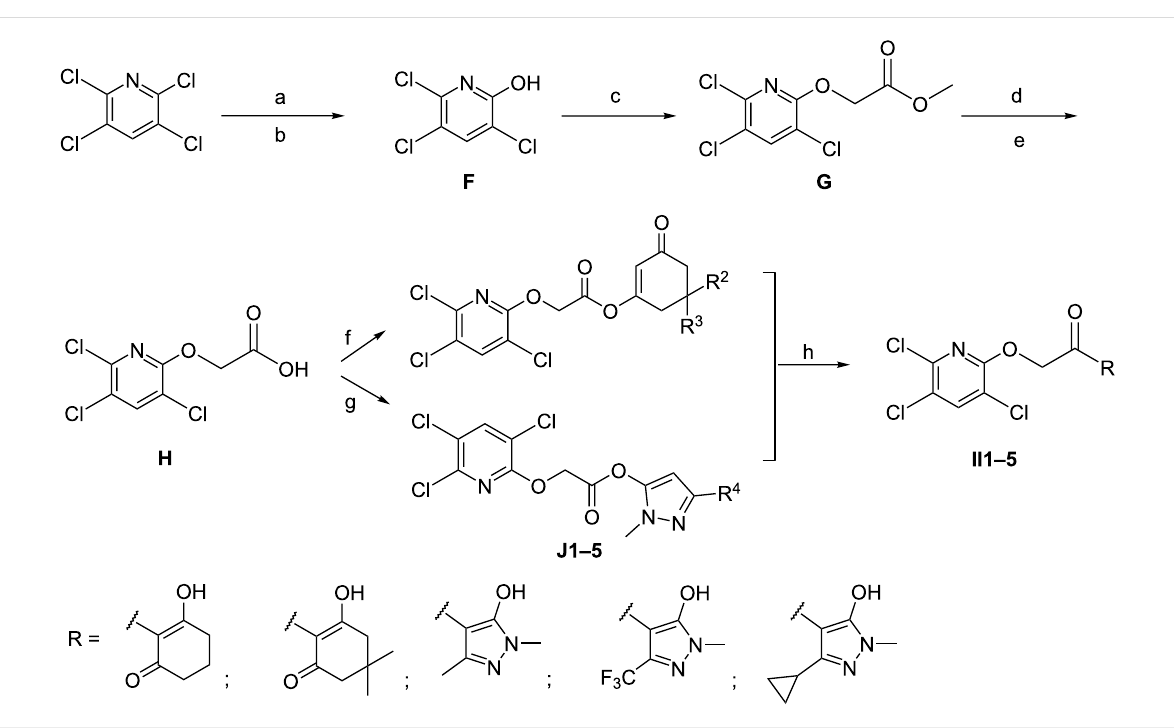
Scheme 4: Synthetic route of the title compounds II . Reagents and conditions: (a) NaOH, TBAB, H 2 O, 100 °C; (b) concentrated HCl solution, rt; (c) methyl chloroacetate, K 2 CO 3 , CH 3 CN, 65 °C; (d) K 2 CO 3 , H 2 O, 65 °C; (e) aqueous HCl solution (10%), rt; (f) substituted 1,3-cyclohexanediones, EDCI, DMAP, DCM, rt; (g) substituted 1,3-dimethyl-1H-pyrazol-5-ol, EDCI, DMAP, DCM, rt; (h) Et 3 N, acetone cyanohydrin, DCM,